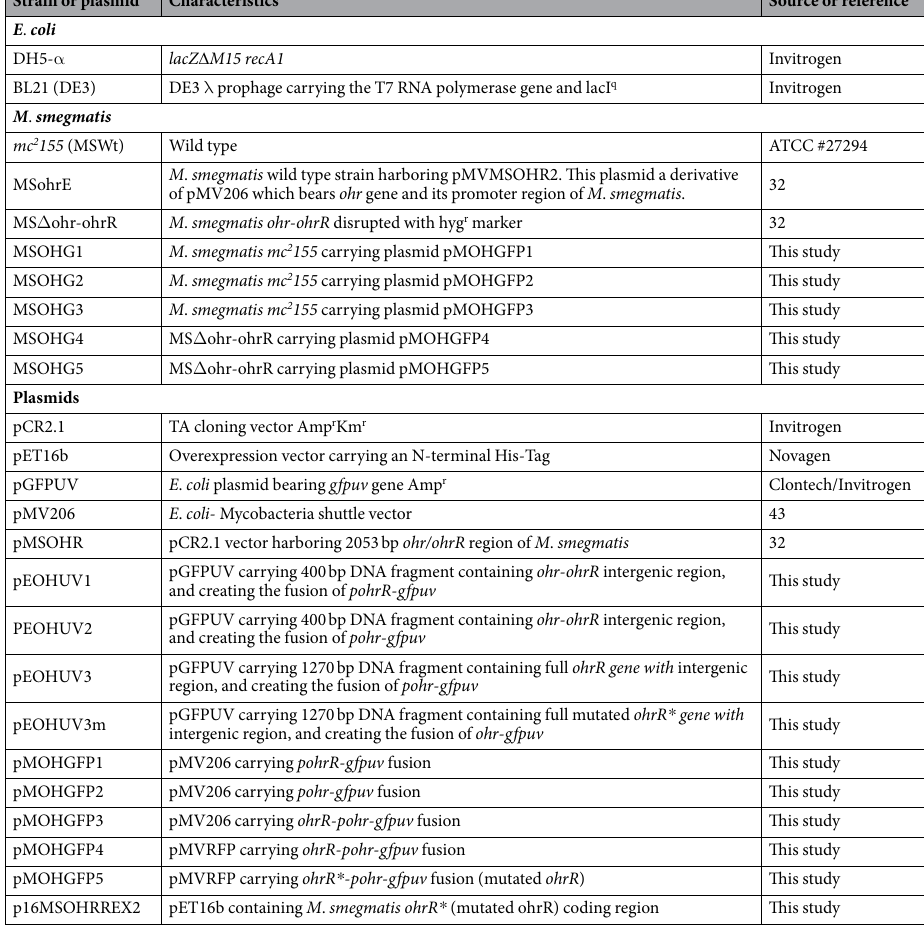
Table 1. Bacterial strains and plasmids used in this